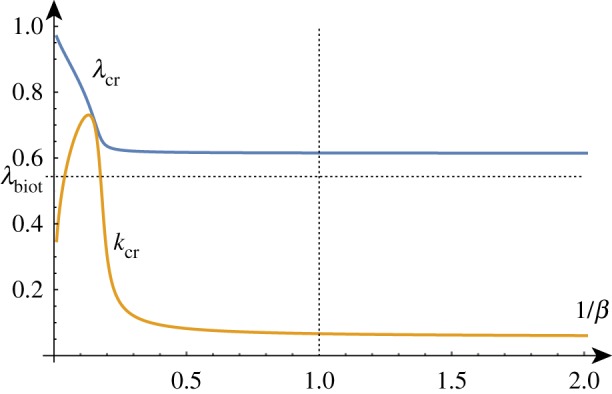
kcr and λcr as functions of β−1 for m = 5/9. (Online version in colour.)